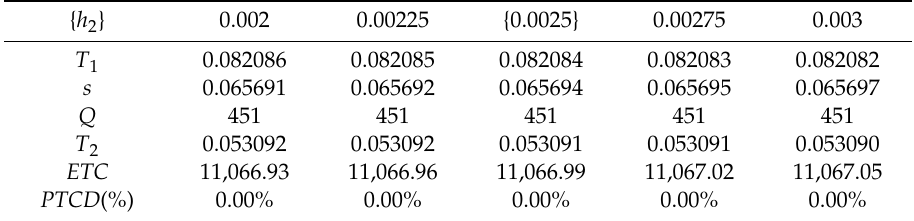
Table 6. Sensitivity analysis when the hazard rate of sold product after inspection changes.